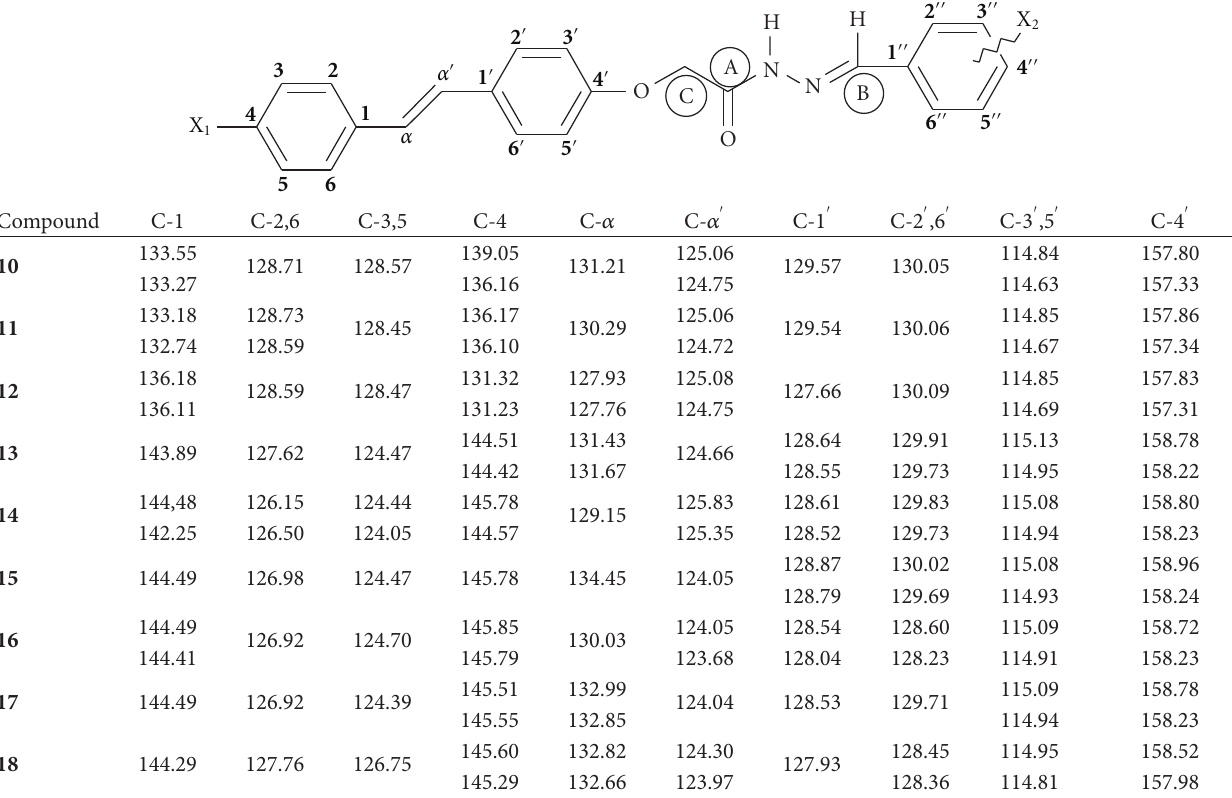
T 7: 13 C NMR data of compounds 10 – 18 —Part A (stilbene carbons); two values given for each carbon atom concern cis and trans